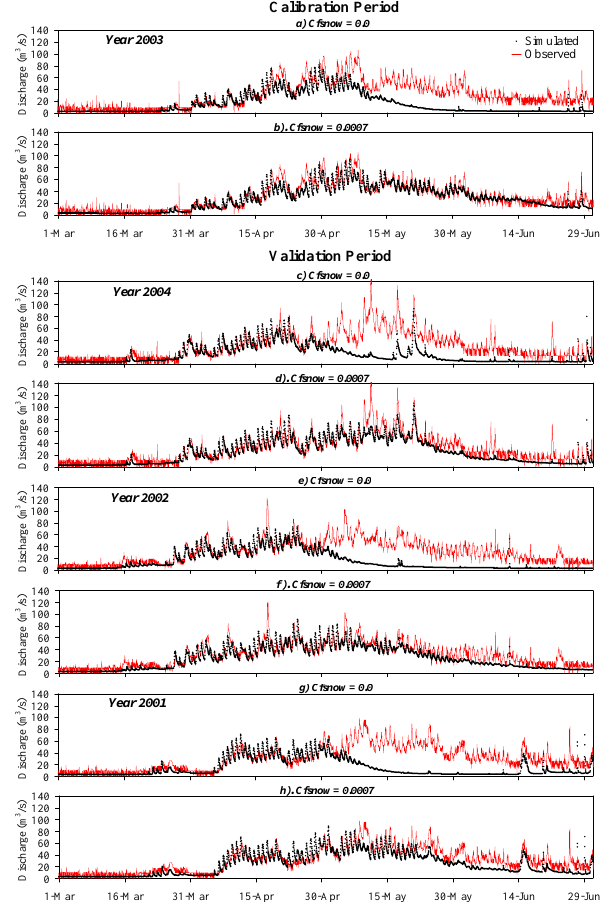
Fig. 4. Observed and simulated hourly discharges at basin out- let from March through June in calibration (2003) and valida- tion (2001, 2002 and 2004) periods, for optimised C fsnow and C fsnow